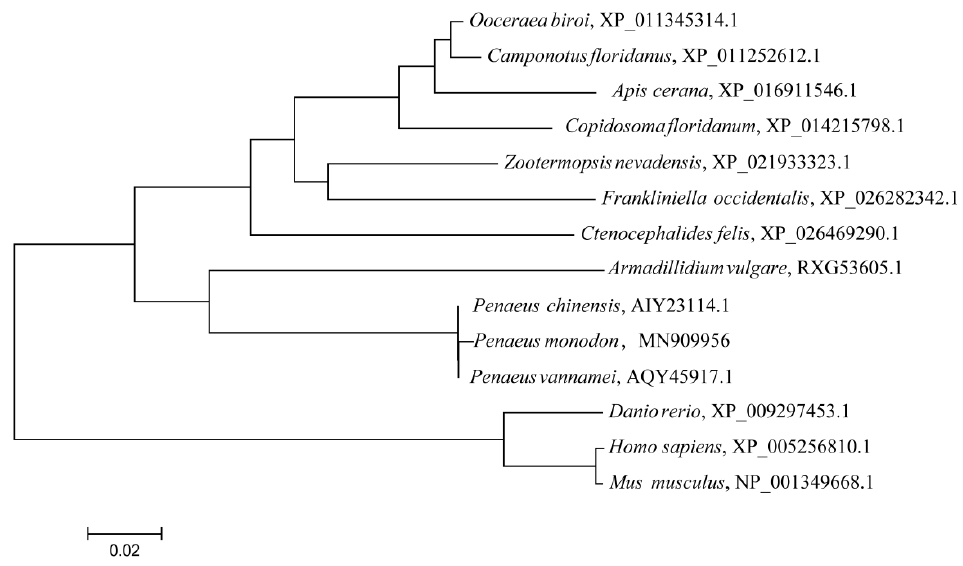
Figure 3. Phylogenetic analysis of P. monodon MKK4 with other reported MKK4 .